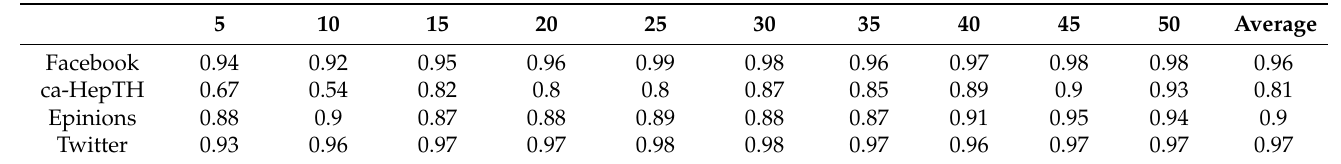
Table 2. Normalized accuracy of IMBR algorithm on different datasets.